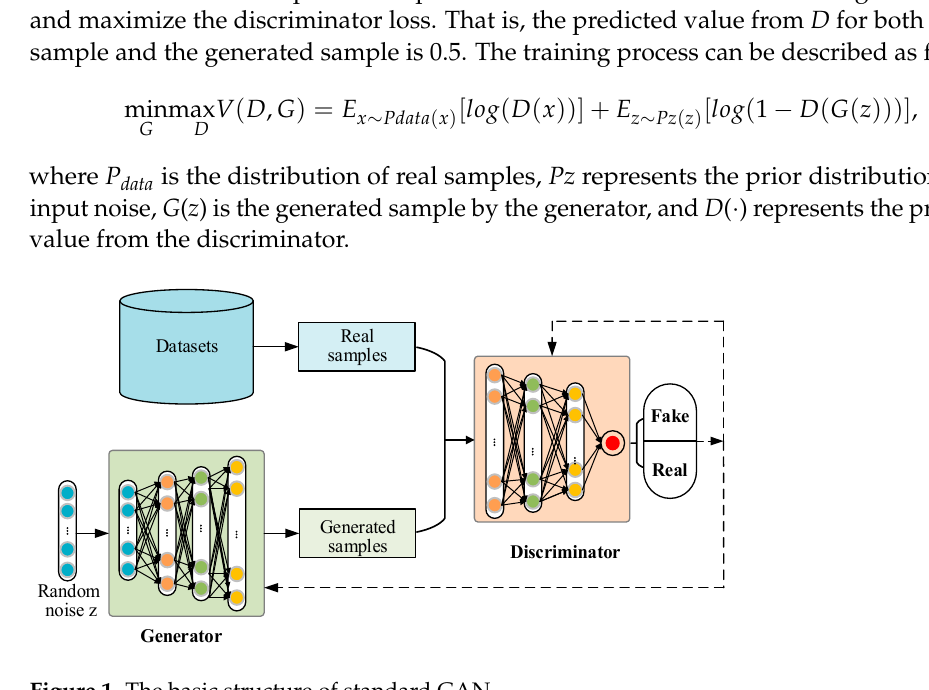
Figure 1. The basic structure of standard GAN.